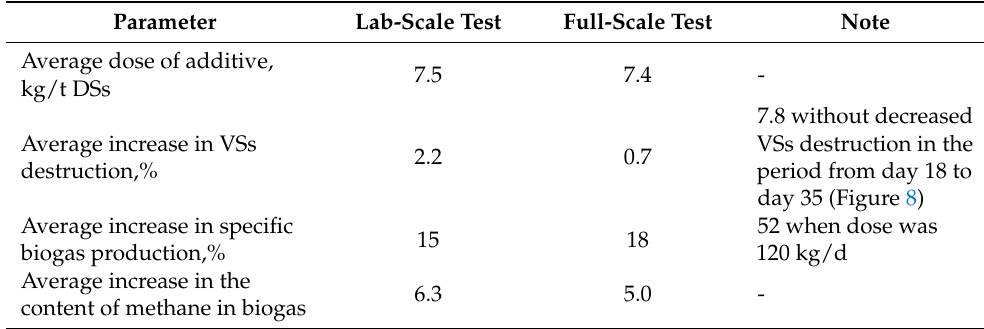
Table 4. Comparison of the results between lab-scale test and full-scale test when additive No 1 is applied. Parameter Lab-Scale